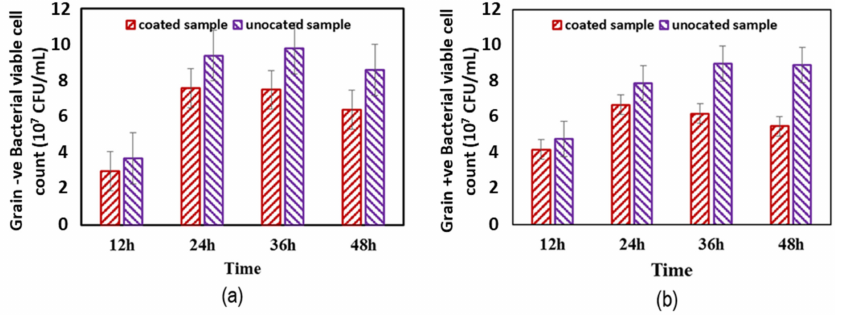
Figure 3. Bacterial viable cell count ( a ) gram -ve bacteria ( E. coli ) ( b ) gram +ve bacteria ( B. Subtilis ). Reprinted with permission from